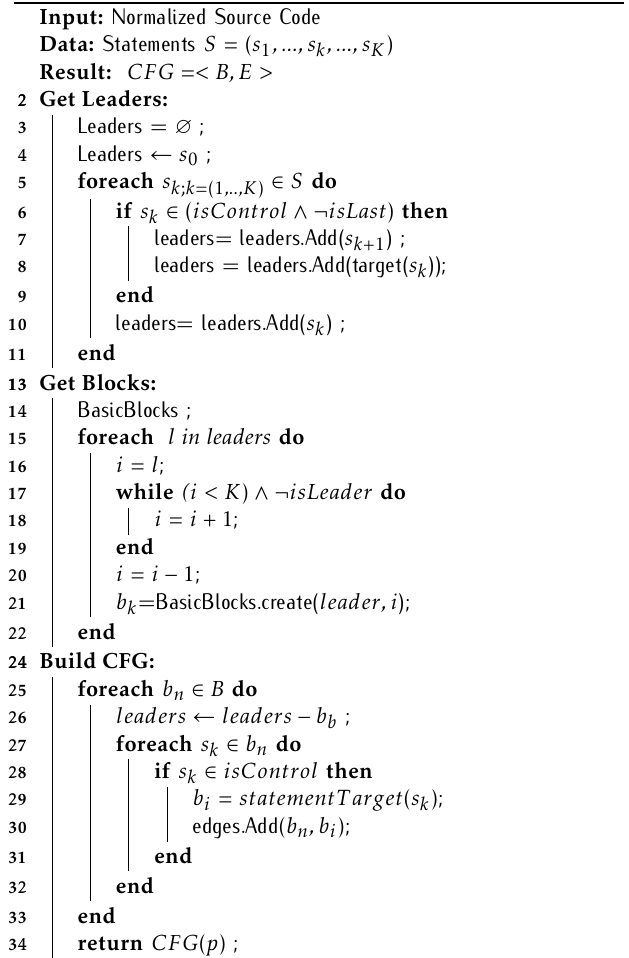
Algorithm 2.1: CFG Extraction Algorithm